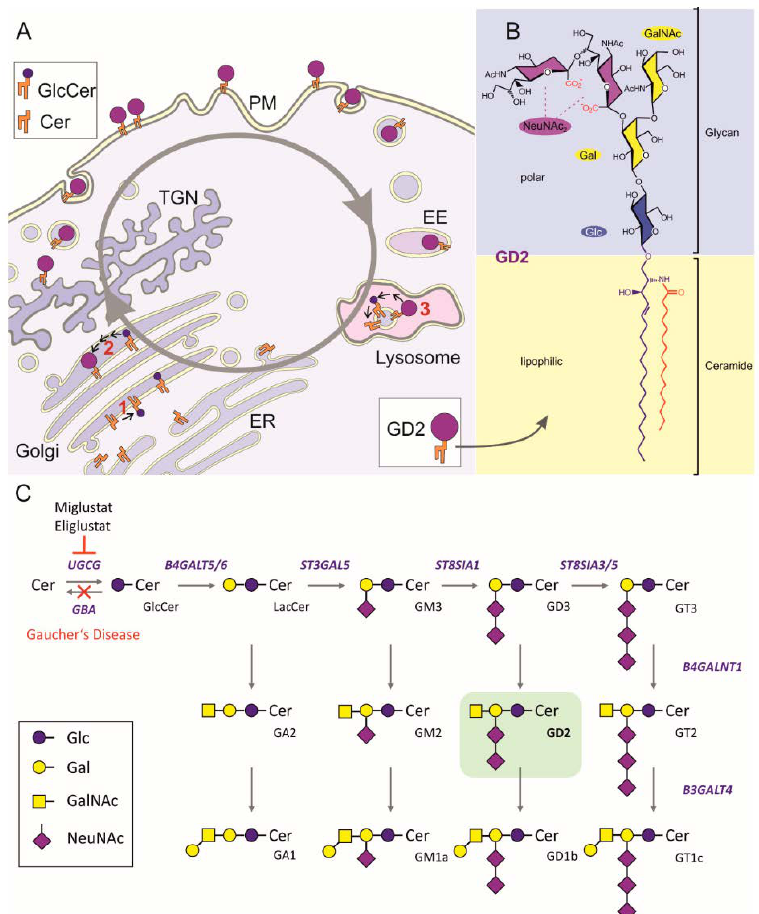
Figure 1. Cellular ganglioside metabolism and structure of GD2. ( A ). Cellular synthesis of the ganglioside GD2 starts with the synthesis of the lipid ceramide at the endoplasmic reticulum (ER). Transported to the Golgi apparatus (Golgi), it is converted by the glucosylceramide synthase (UGCG, 1) and subsequently luminal acting glycosyltransferases (2) into GD2 before it reaches the plasma membrane (PM) by vesicular transport from the trans Golgi network (TGN). Exposed to the outer leaflet of the PM, it may facilitate cell–cell contacts or modulate laterally the activity of plasma membrane proteins. Concentration of GD2 at the PM is further regulated by endocytic uptake of GD2, transport to early endosomes (EE), and stepwise lysosomal degradation into its sugar building blocks, free fatty acids, and sphingosine (3). The latter can be used again by the salvage pathway for production of ceramide at the ER. ( B ). Chemical structure of the ganglioside GD2 showing its lipophilic ceramide anchor, which is composed of a sphingoid base (blue) and a fatty acid (red), and the polar glycan head group. The latter is composed of a neutral core trisaccharide containing a terminal N-acetyl galactosamine (GalNAc) linked to a galactose (Gal), which is bound to the ceramide connected glucose (Glc). This trisaccharide is extended by two N-acetyl neuraminic acids (NeuNAc) attached to the galactosyl residue. ( C ). Combinatorial biosynthesis of gangliosides including GD2 (on green background) begins with the condensation of UDP-glucose and ceramide (Cer) to form glucosylceramide (GlcCer). This step is catalyzed by the glucosylceramide synthase (UGCG), which is inhibited by the small molecular compounds Eliglustat and Miglustat. By further glycosyl transferases (B4GALT5/6, ST3GAL5, ST8SIA1, and ST8SIA3/5) GlcCer is converted to lactosylceramide (LacCer) and the gangliosides GM3, GD3, and GT3, all of which are substrates for the GalNAc transferase B4GALNT1, leading to more complex structures GA2, GM2, GD2, and GT2. The latter may then be glycosylated by the galactosyl transferase B3GALT4 to produce GA1, GM1a, GD1b, and GT1c. GM1a, GD1b, and GT1c as well as GD1a (not included into scheme) are the main gangliosides of the brain. Lysosomal degradation of gangliosides is a stepwise process leading finally again to GlcCer, which is cleaved by lysosomal glucocerebrosidase (GBA). Deficiency of GBA causes the lysosmal storage disease Gaucher’s Disease. Substrate deprivation therapy with Eliglustat or Miglustat by inhibiting UGCG is one possibility to treat Gaucher’s